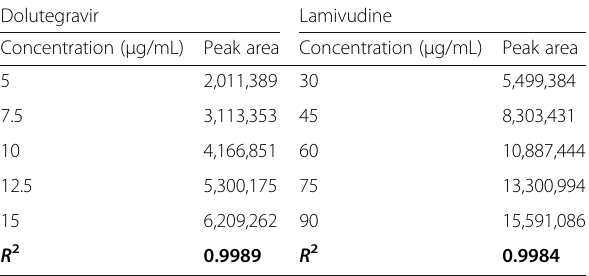
Table 3 Peak areas of linearity standard solutions of Dolutegravir and Lamivudine Dolutegravir Lamivudine